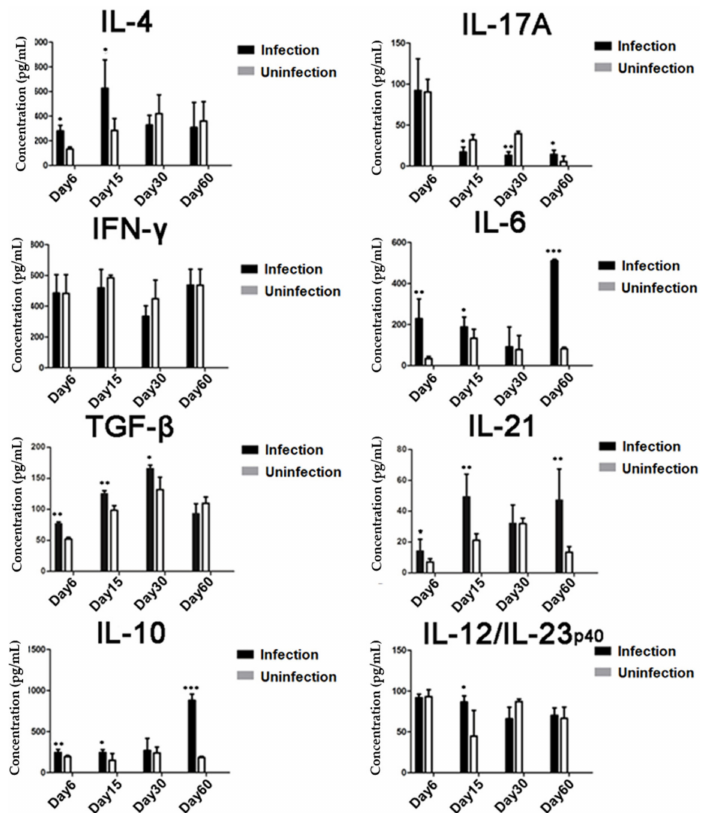
Figure 2. Cytokine profile measured in the culture of splenocytes isolated from T. spiralis -infected mice: On days 6, 15, 30, and 60 after infection with T. spiralis , four infected mice at each time point were sacrificed and splenocytes were isolated. The culture supernatants were collected after being incubated with phorbol 12-myristate 13-acetate (PMA) and ionomycin for 72 h, and the concentrations of IL-4, IL-17A, IFN- γ , IL-6, TGF- β , IL-21, IL-10, and IL-12 / 23p 40 were measured by ELISA. Data are representative of three independent experiments, expressed as means ± SDs, * p < 0.05; ** p < 0.01; *** p < 0.001, compared to the uninfected